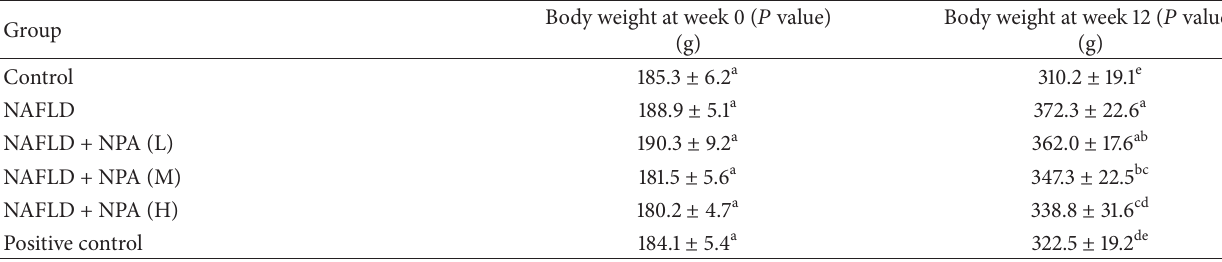
Table 1: Body weight changes of rats during NAFLD development.